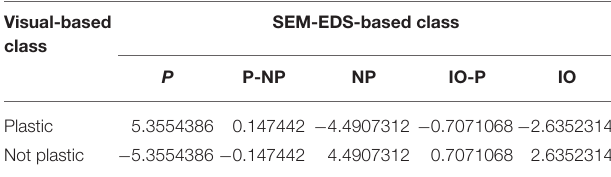
TABLE 2 | Residuals of chi-squared test of independence performed on the contingency table (Supplementary Table 3) that related the number of samples visually deemed as plastic and not plastic vs. their SEM-EDS-based classification into plastic (P), non-plastic organic (NP), and inorganic (IO) particles. Visual-based class